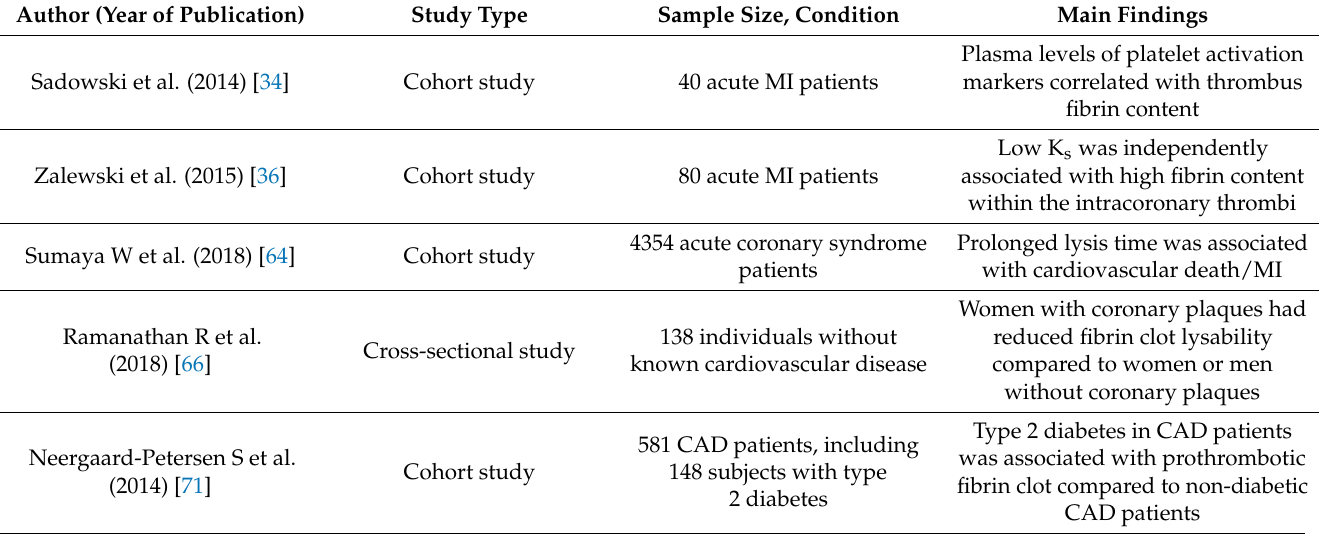
Table 2. Table summarizing the recent data on plasma fibrin clot properties, including fibrin clot permeability (K s ) and clot lysis time (CLT) in atherosclerotic